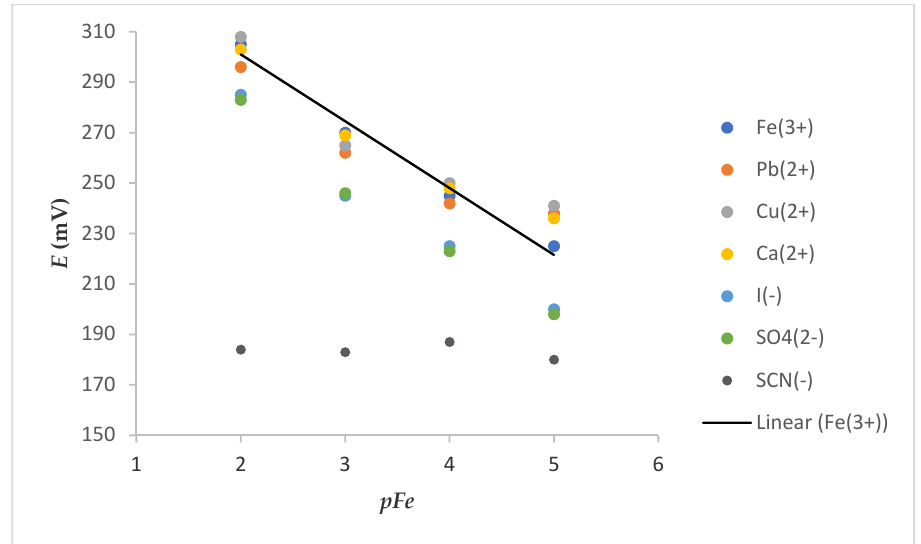
Figure 6. Calibration curves for determination of Fe 3+ with commercial and 7S fluoride ion-selective electrode (FISE).